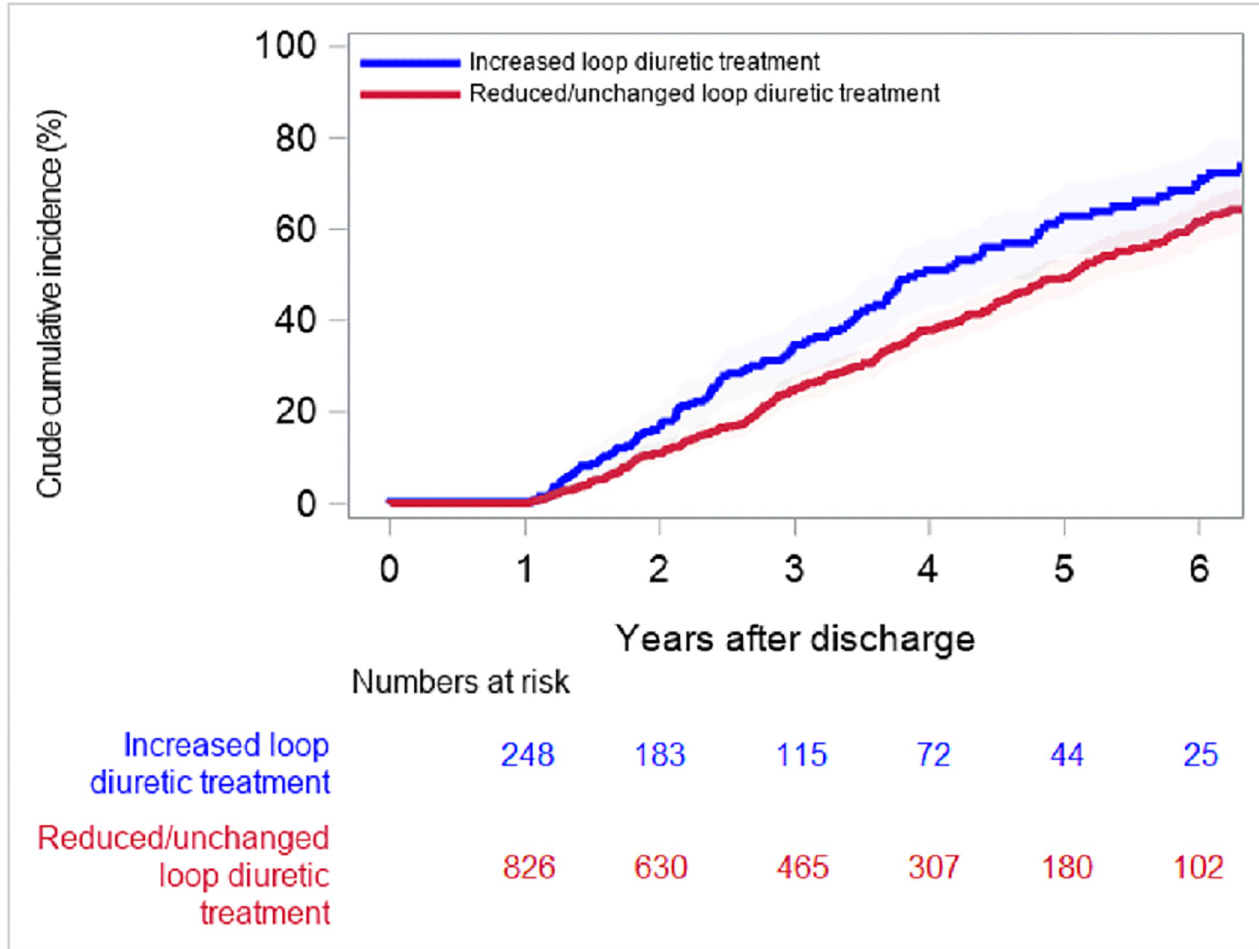
Fig 5. Cumulative incidence of death among patients alive one year after discharge for TAVI procedure, with a medical history of heart failure and loop diuretic treatment post-procedure. Abbreviations: TAVI, transcatheter aortic valve implantation.